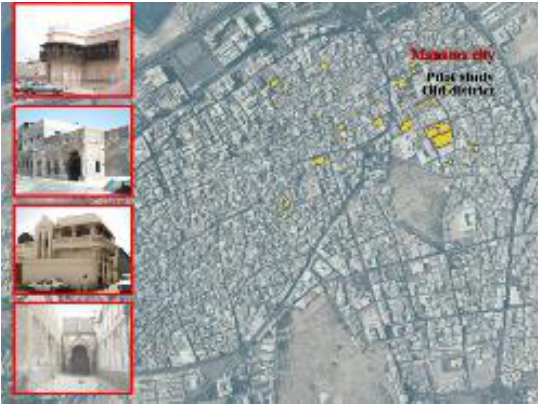
Figure 7. Urban context of the study area, google earth map,